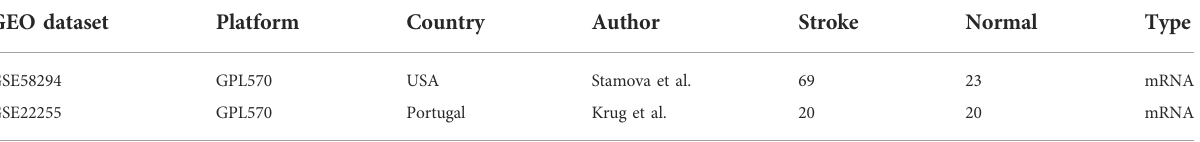
TABLE 1 Detailed information of the gene expression matrixes and platform. GEO dataset